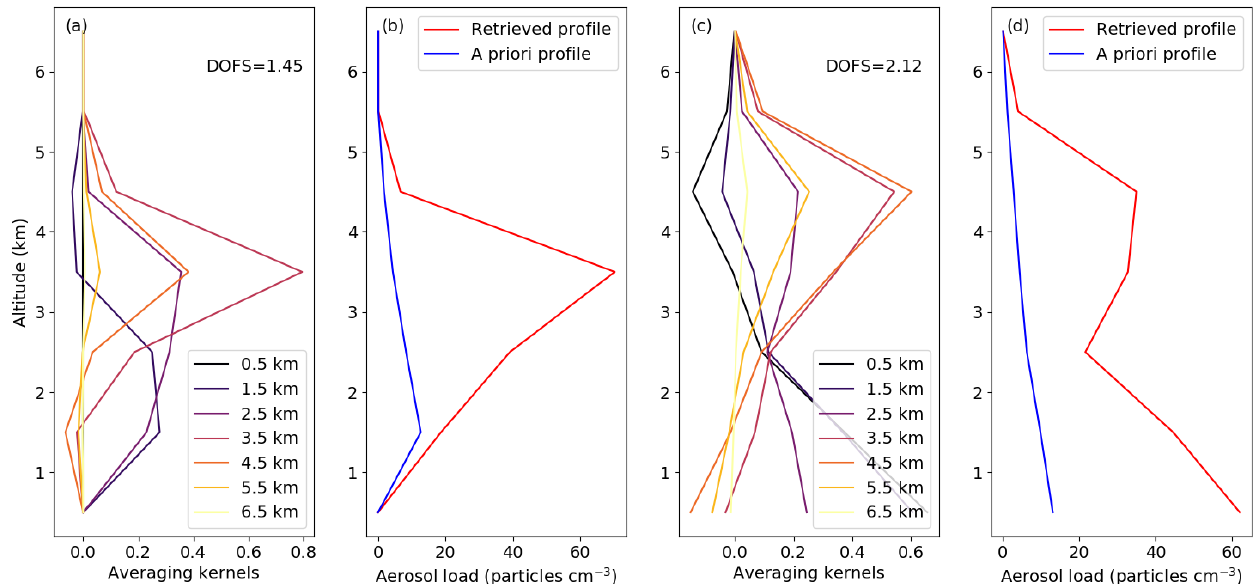
Figure 2. Averaging kernels and associated retrieved profile at two different locations: (a, b) 14 . 97 ◦ N, 23 . 7 ◦ E on 12 March 2016 and (c, d) 28 . 99 ◦ N, 5 . 3 ◦ E on 27 May 2016. Degrees of freedom (DOFs) are also